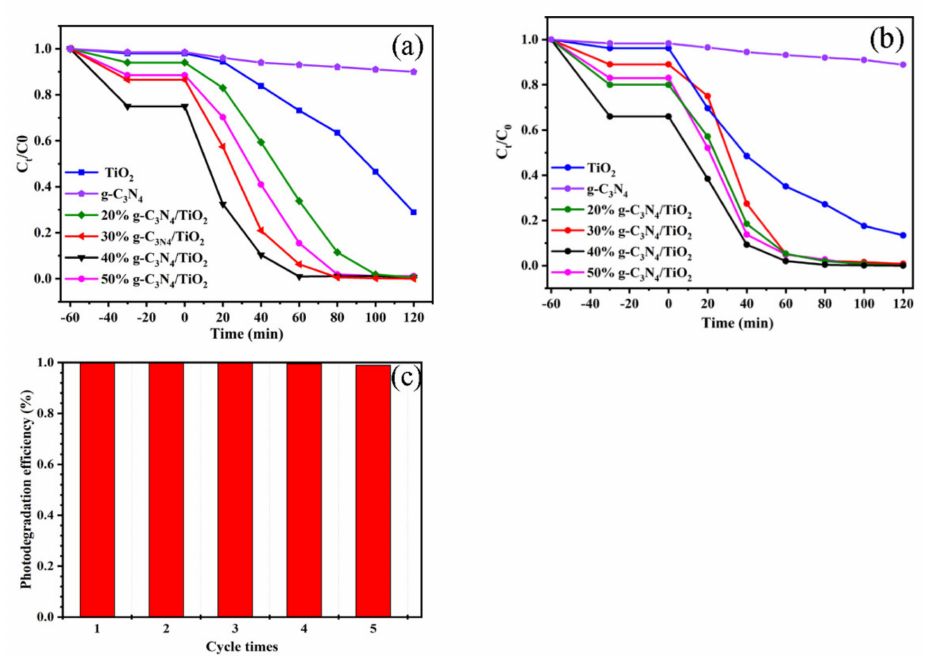
Figure 7. The photodegradation curves for methyl orange ( a ) and the photodegradation curves for rose red ( b ) with g-C 3 N 4 , TiO 2 , and g-C 3 N 4 /TiO 2 composite; the methyl orange cycling photodegradation experiments with 40% g-C 3 N 4 /TiO 2 composite ( c